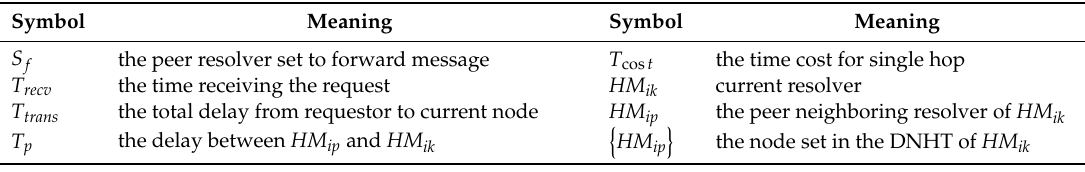
Table 2. The meaning of symbols in Algorithm 2.